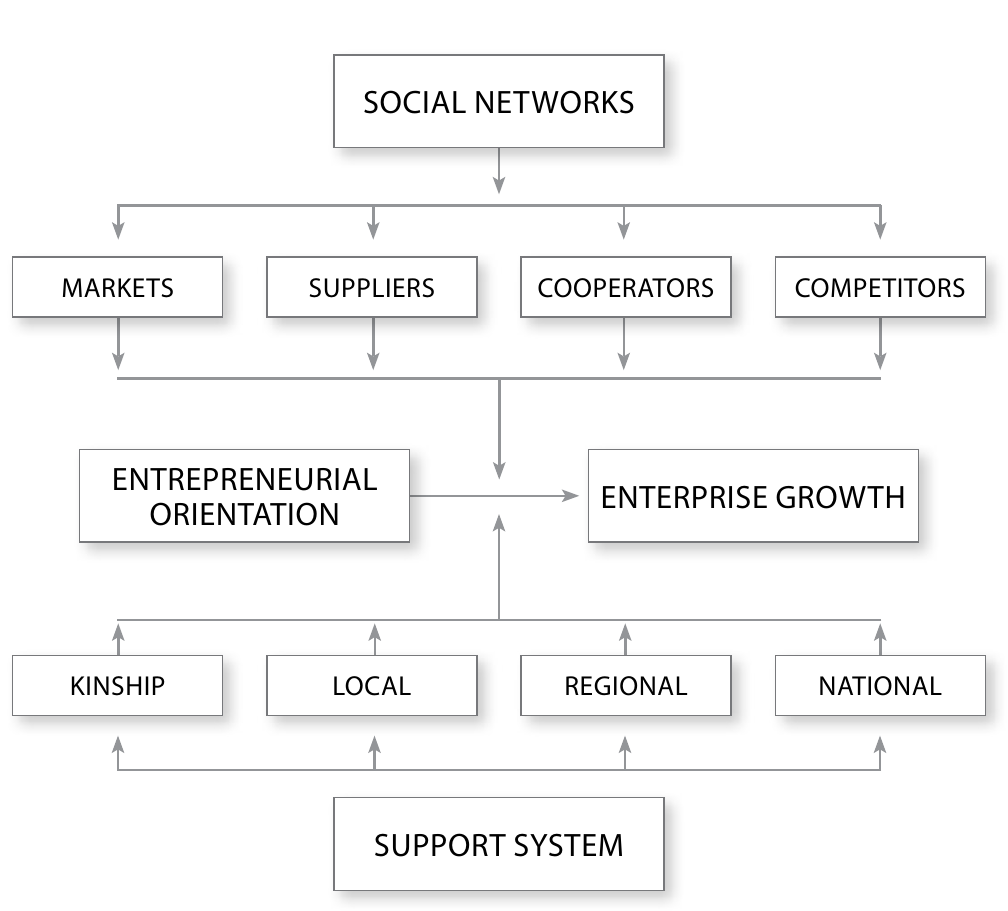
Figure 1: Theoretical model of entrepreneurship orientation in a geographical context (based on Schnell et al.,